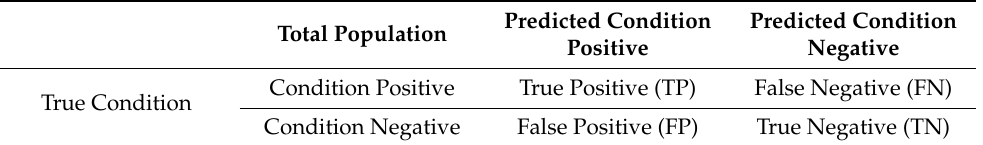
Table 1. The confusion matrix of a single label